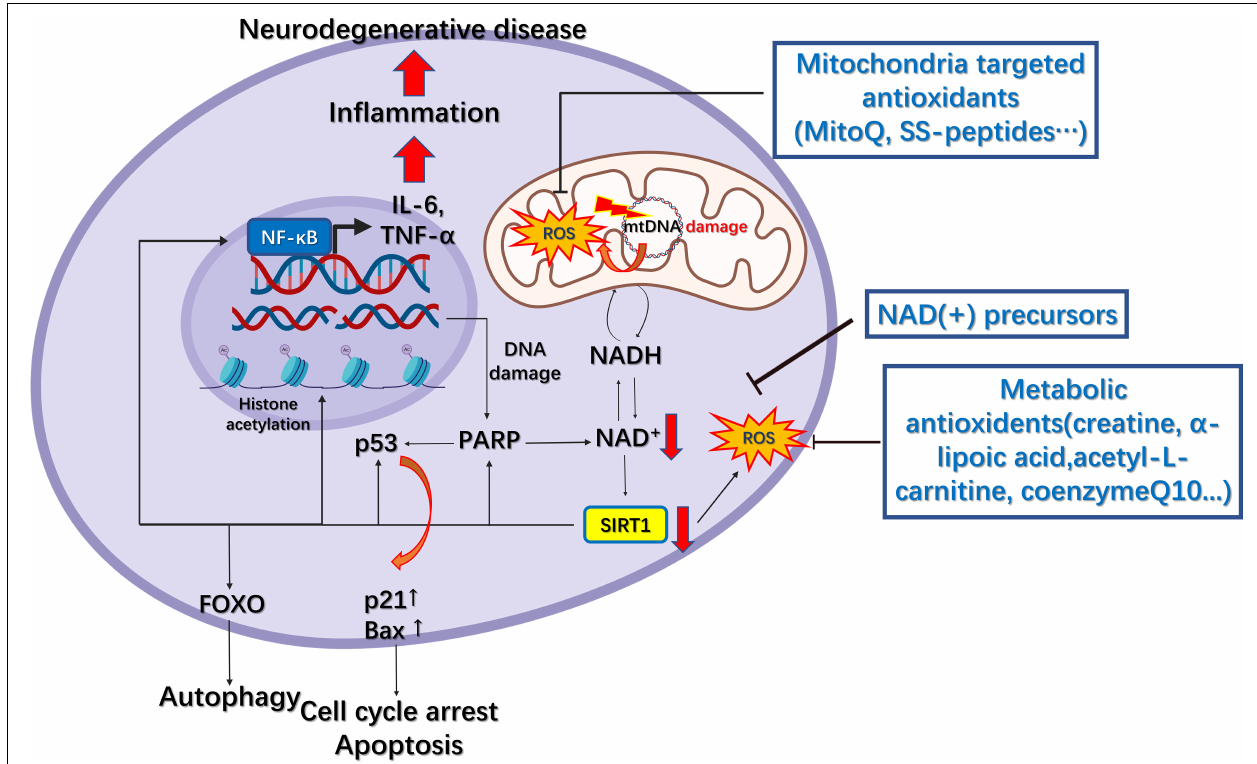
FIGURE 4 | Mitochondrial pharmacology in neurodegenerative diseases. The downregulation of NAD(+) following DNA damage results in decreased SIRT1 activity, which leads to decreased deacetylation of FOXO, p53, and NF- κ B and elevated levels of reactive oxygen species (ROS). This results in increased autophagy, cell cycle arrest, apoptosis, inflammation, and further DNA damage, finally leading to neurodegenerative disease. Several metabolic and mitochondria-targeted antioxidants have been developed to increase NAD(+) levels and reduce those of